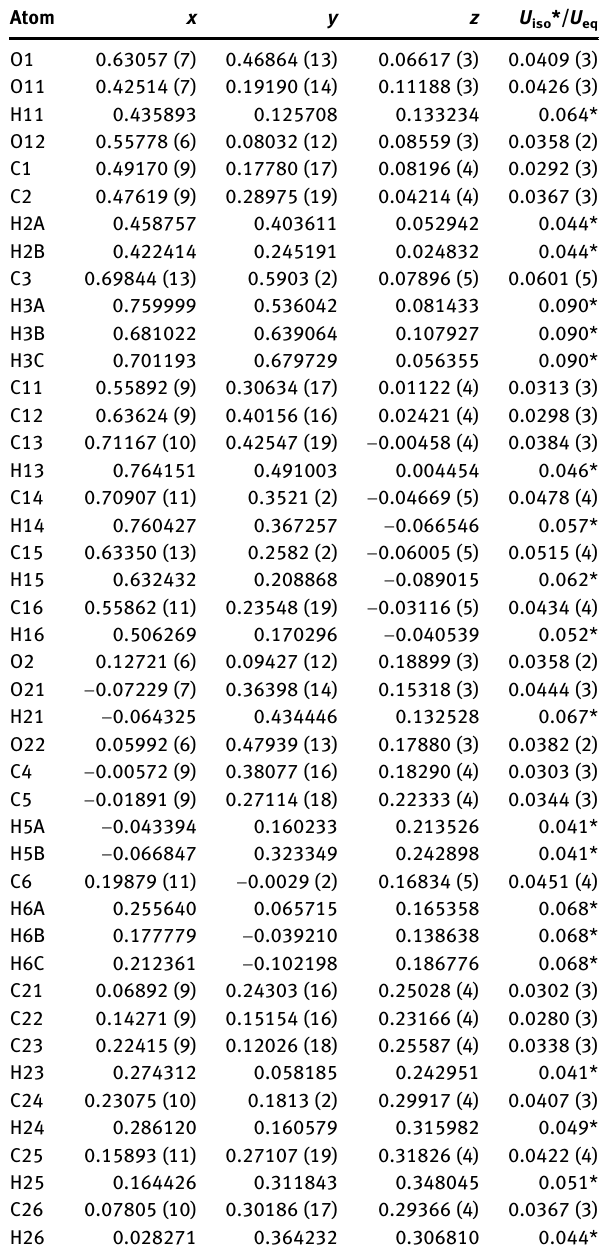
Table  : Fractional atomic coordinates and isotropic or equivalent isotropic displacement parameters (Å 